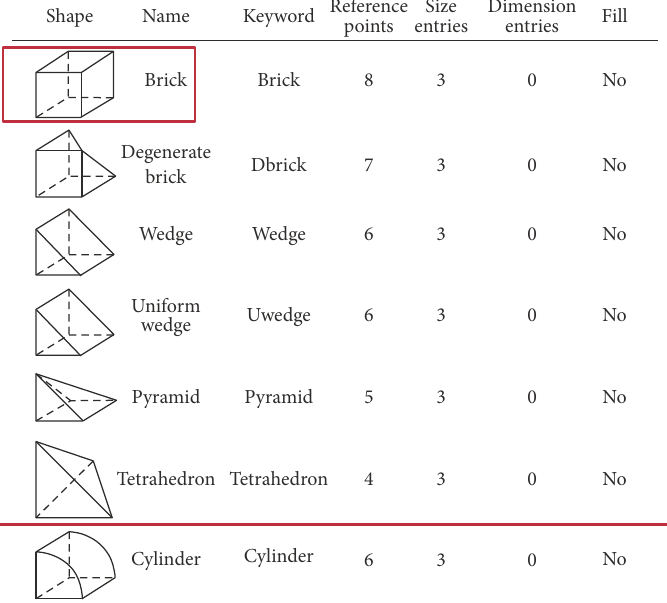
Figure 2: Specifications of the used elements [16].